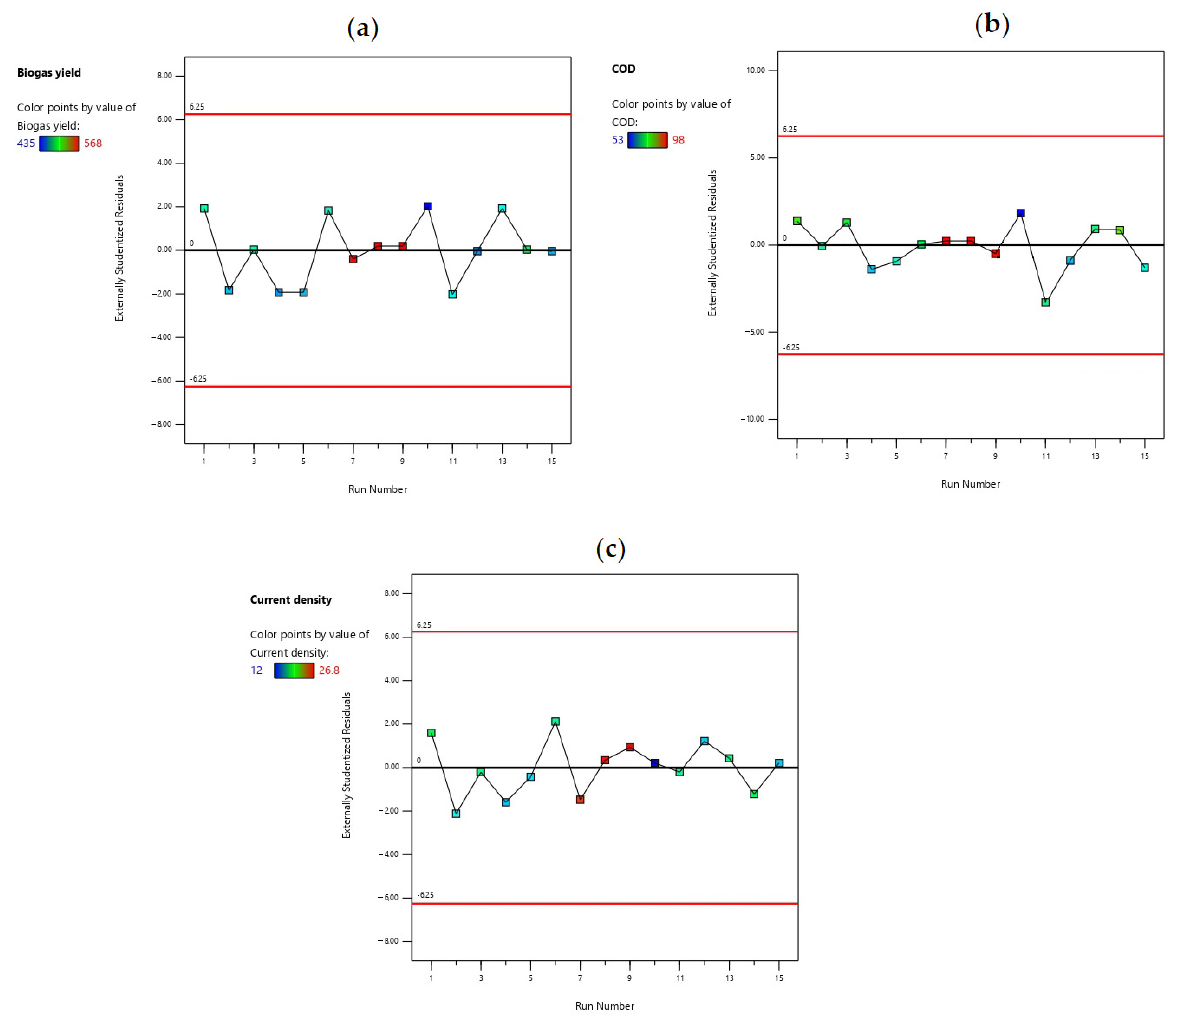
Figure 4. Residuals versus experimental runs for ( a ) biogas yield; ( b ) %COD removed; and ( c ) current density.